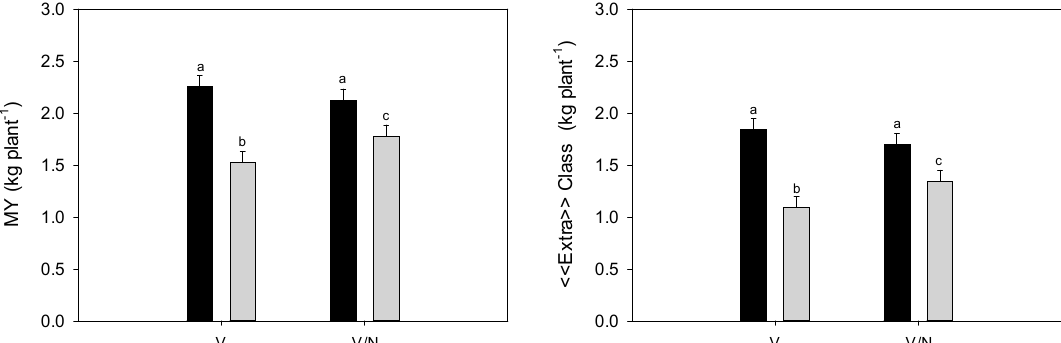
Figure 6. Marketable yield (MY, kg plant − 1 ) and «Extra» Class yield («Extra» Class, kg plant − 1 ) for the deficit irrigation plants (gray bars) and the control plants (black bars) in the ungrafted pepper plants (V) and the cultivar grafted onto NIBER ® (V / N). Data are the mean values for n = 6. In each plant combination, di ff erent letters indicate significant di ff erences at p ≤ 0.05. Error bars represent the LSD value of the interaction.